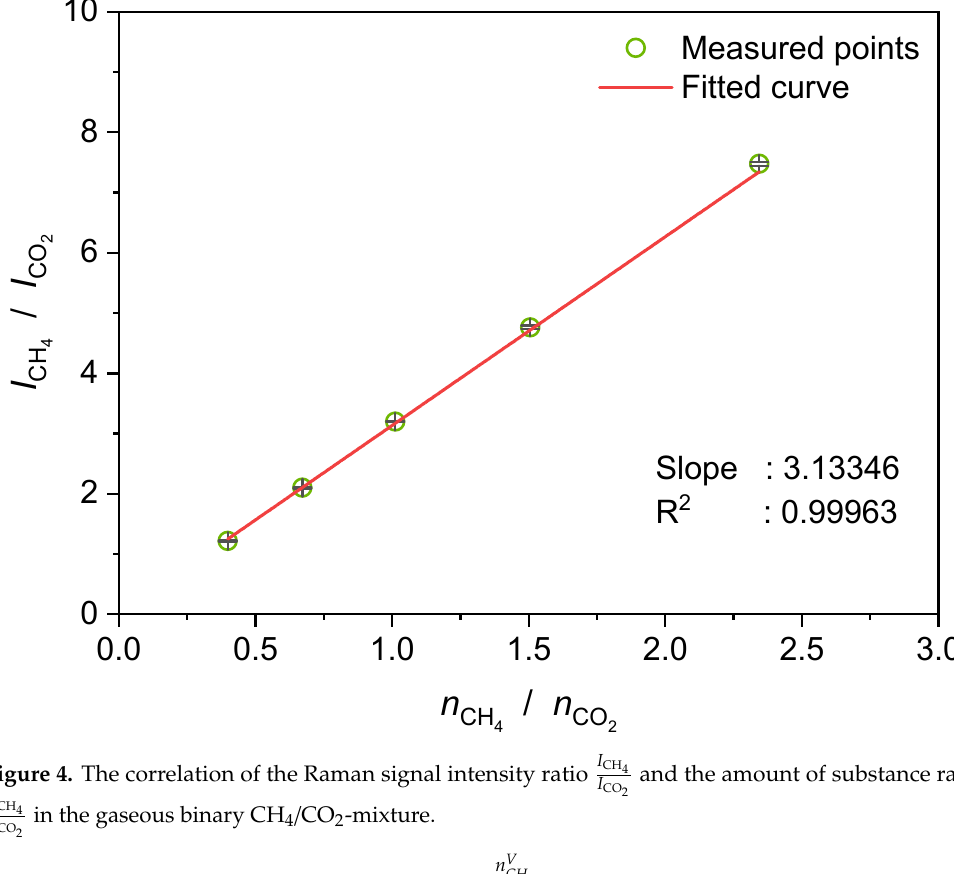
Figure 4. The correlation of the Raman signal intensity ratio n CH4 n CO2 in the gaseous binary CH 4 /CO 2 ‐ mixture.